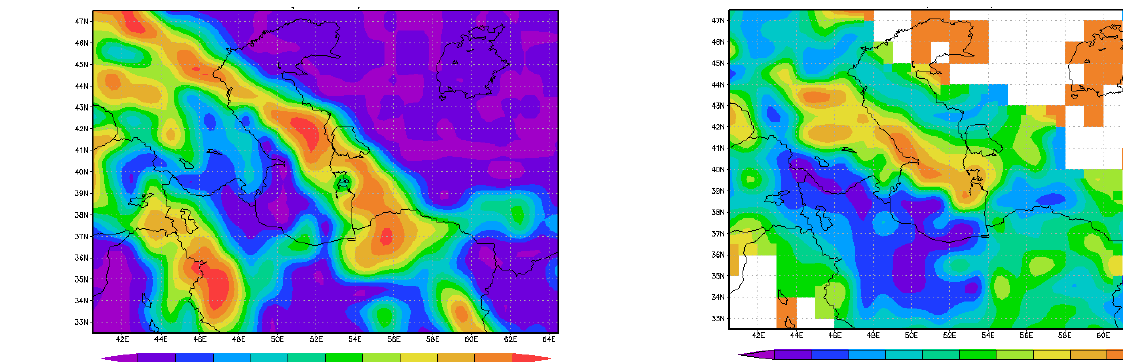
Figure 9. Cloud top Temperature from MODIS, Aqua at 10:20 UTC On second of June 2014.